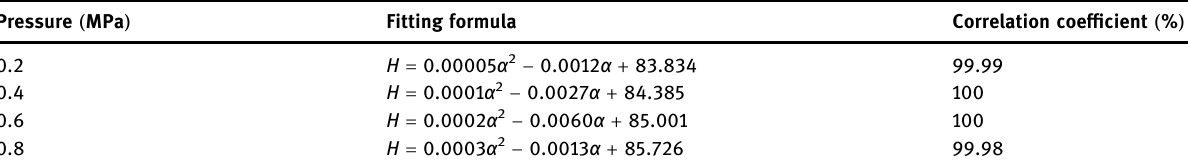
Table 5: Function expression of maximum deformation height and angle under di ff erent pressures Pressure ( MPa )